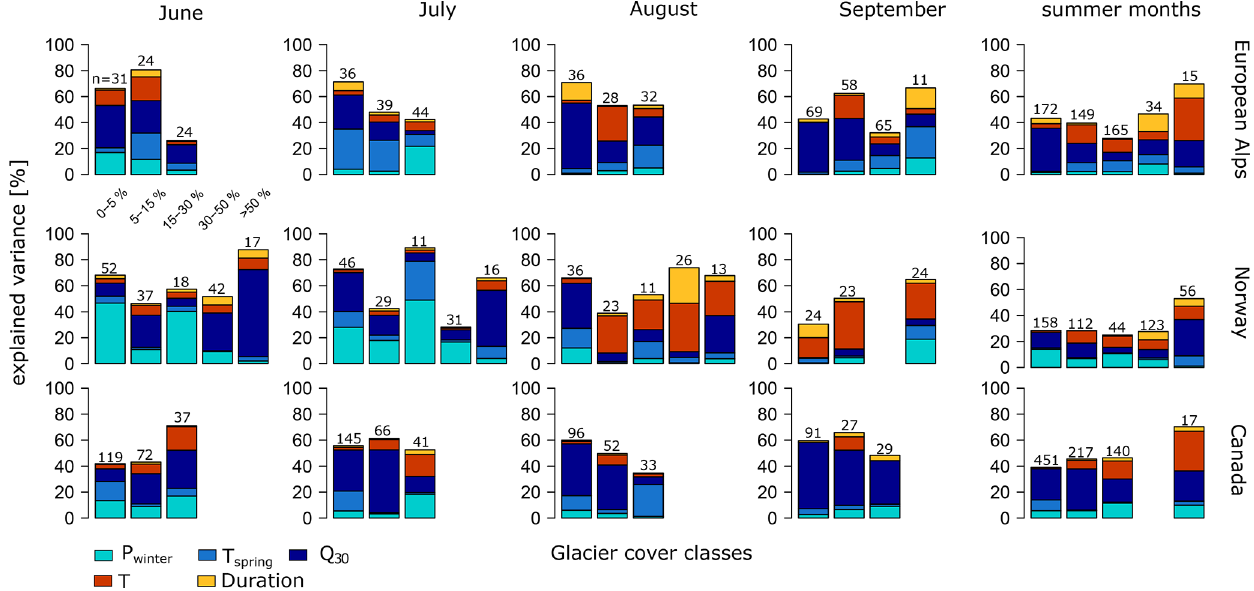
Figure 8. Explained variance in C during WD events for groups of catchments with similar glacier cover. The glacier cover classes are indicated on the top left bar plot. No bar is present if there were less than 10 events for a gc class and month. The number above the bars indicates the number of events used in the regression model.